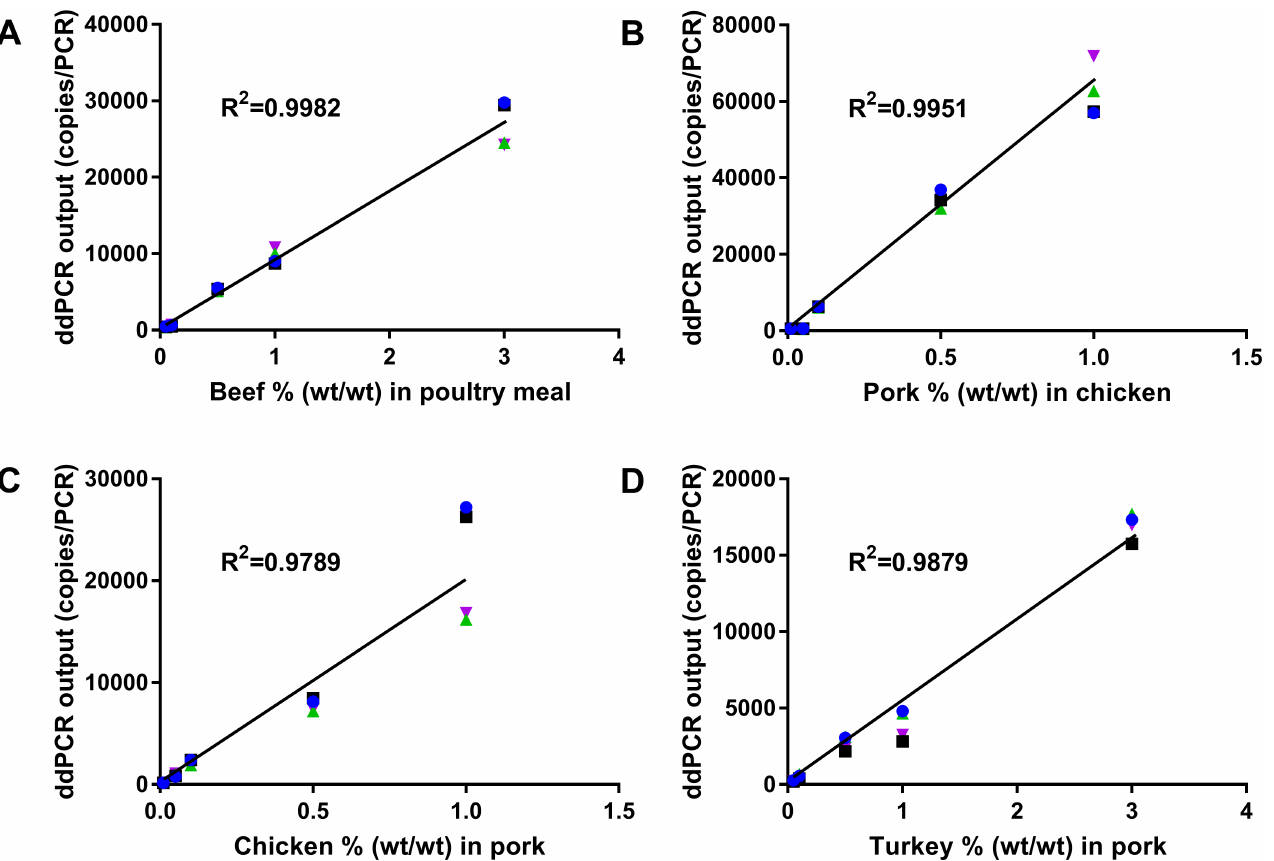
Fig 2. Linear regression between ddPCR output (copies/PCR) and target animal species concentration (% wt/wt) in fortified heat- processed samples. (A) beef in poultry meal, (B) pork in chicken, (C) chicken in pork, and (D) turkey in pork. Shownare results from four replicates in green, blue, purpleand